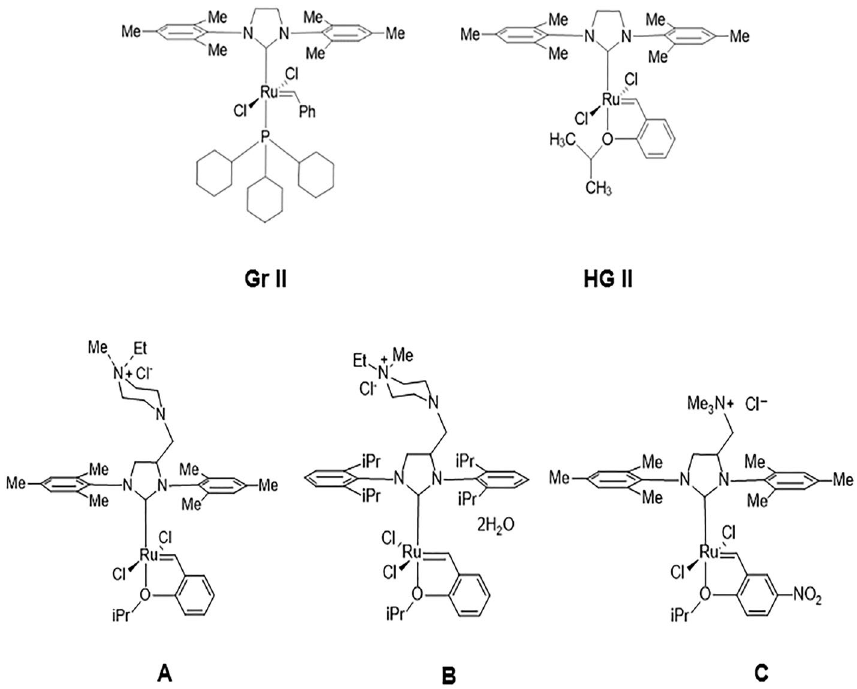
Figure 1. Catalysts used in this study. Type 1—Gr II: Grubbs second generation catalyst; HG II: Hoveyda- Grubbs second generation catalyst. Type 2—( A ) [1,3-Bis(2,4,6-trimethylphenyl)-4-[(4-ethyl-4-methylpiperazin- 1-ium-1-yl)methyl]imidazolidin-2-ylidene]-(2-i-propoxybenzylidene)dichlororuthenium(II) chloride AquaMet; ( B ) (1,3-Bis(2,6-diisopropylphenyl)-4-((4-ethyl-4-methylpiperzain-1-ium-1-yl)methyl)imidazolidin-2- ylidene) (2-isopropoxybenzylidene)ruthenium(II)chloride dihydrate FixCa; and ( C ) 1,3-Bis(2,4,6-trimethylphenyl)-4- [(trimethylammonio)methyl]imidazolidin-2-ylidene]-(2-i-propoxy-5-nitrobenzylidene)dichlororuthenium(II) chloride nitro-StickyCat